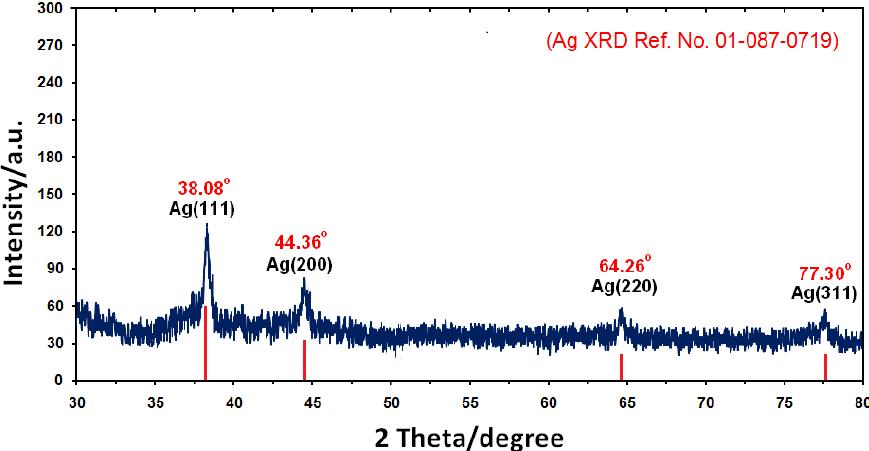
Figure 3. XRD patterns of Ag-NPs synthesized in Callicarpa maingayi for determination of Ag-NPs after 48